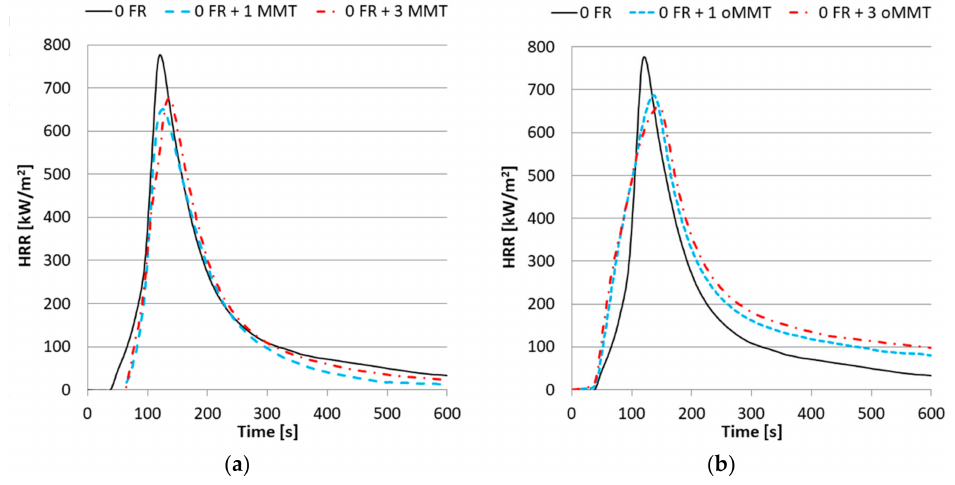
Figure 7. Heat Release Rate curves of nanocomposites with ( a ) MMT filler; ( b ) oMMT filler.